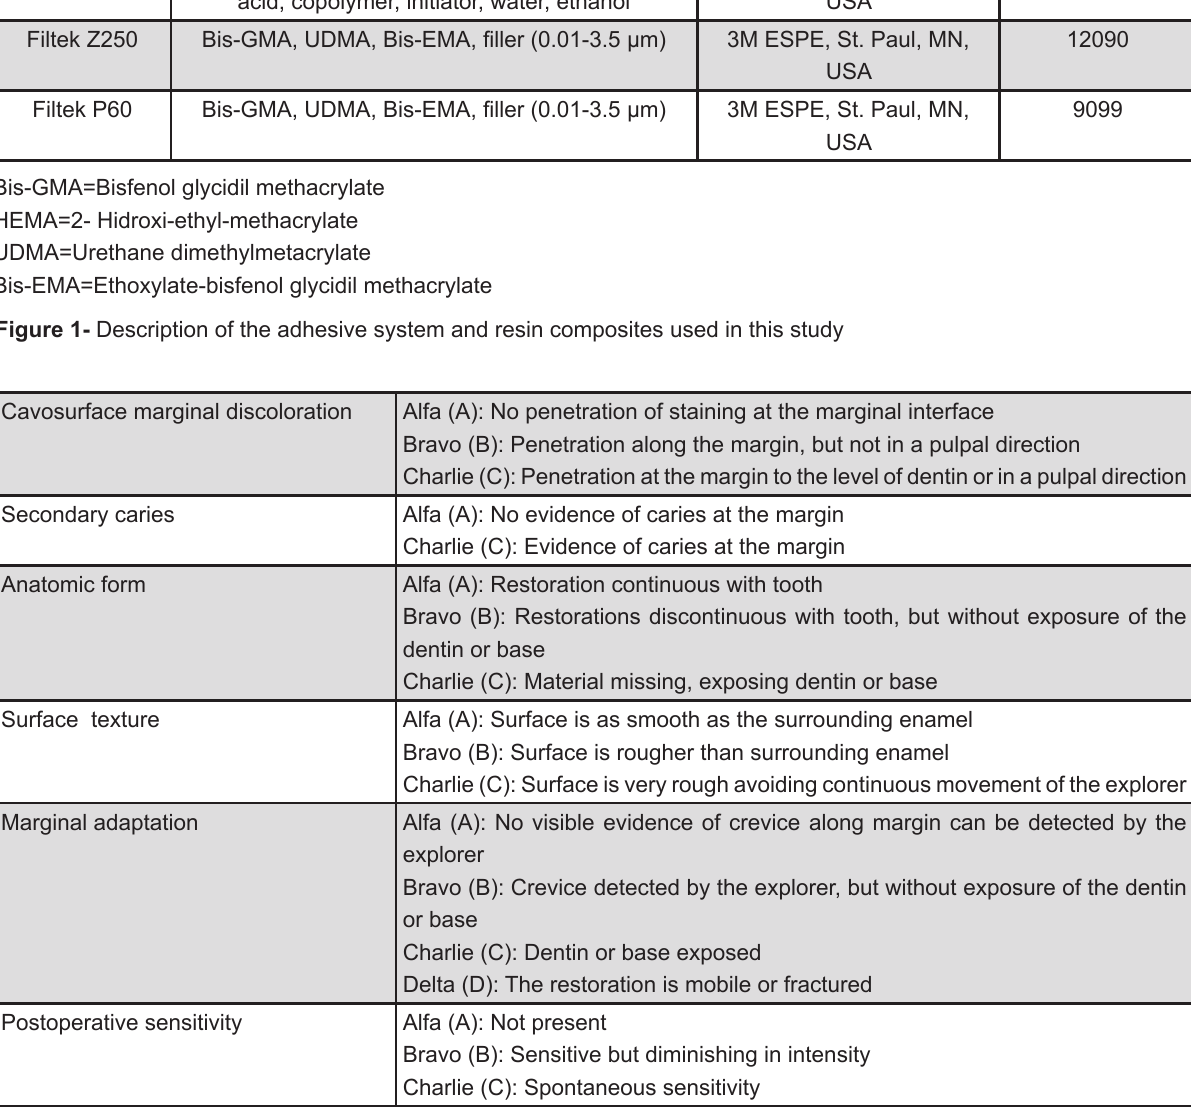
Figure 2- Modified United States Public Health Service (USPHS) criteria and parameters used for the clinical evaluation of